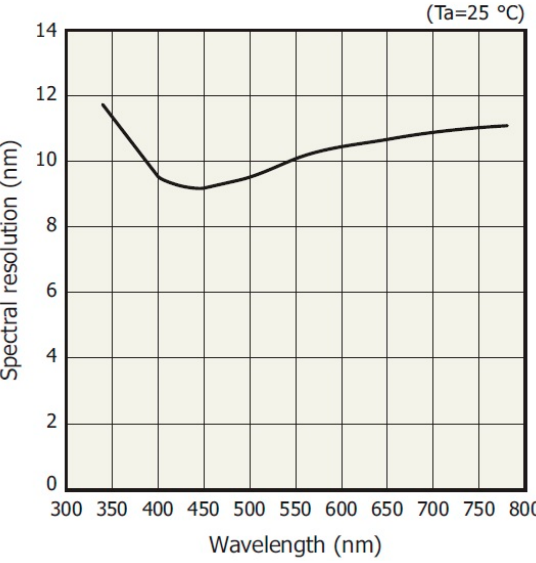
Figure 8. Typical spectral resolution vs. wavelength of the MEMS sensor [23].